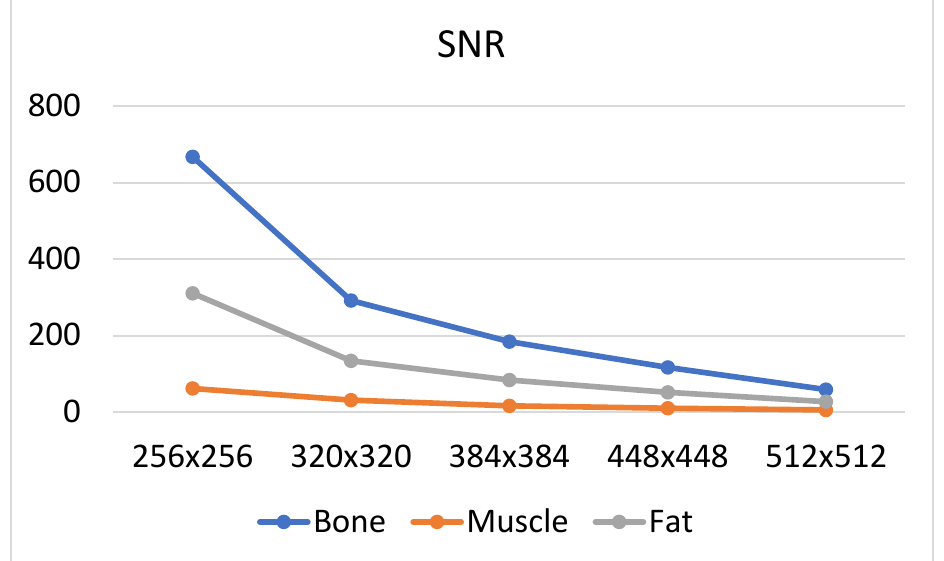
Figure 11. Mean SNR values (averaged for all patients) evaluated for all matrices and analyzed tissues.